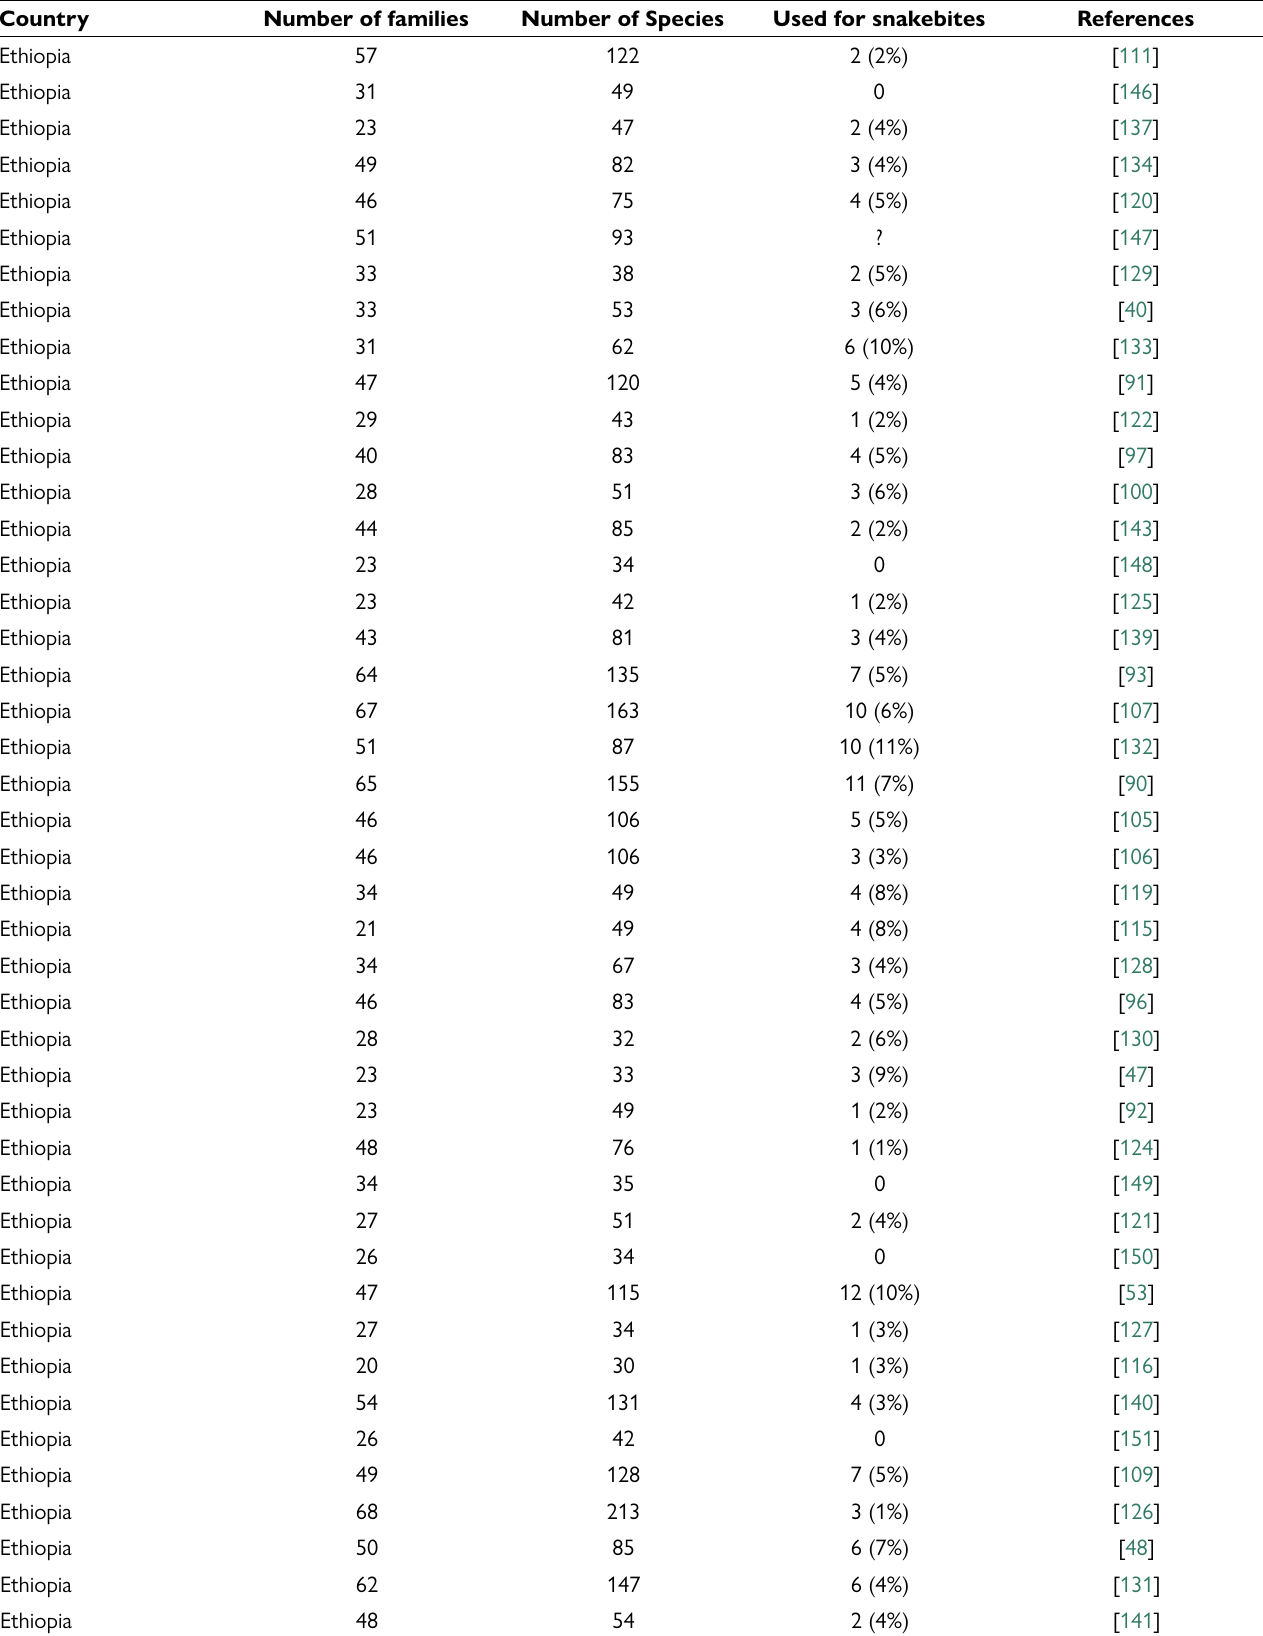
Table 3. Number of ethnomedicinal plant species used against snakebites (preventive and curative) in Ethiopia and some sub-Saharan African countries.